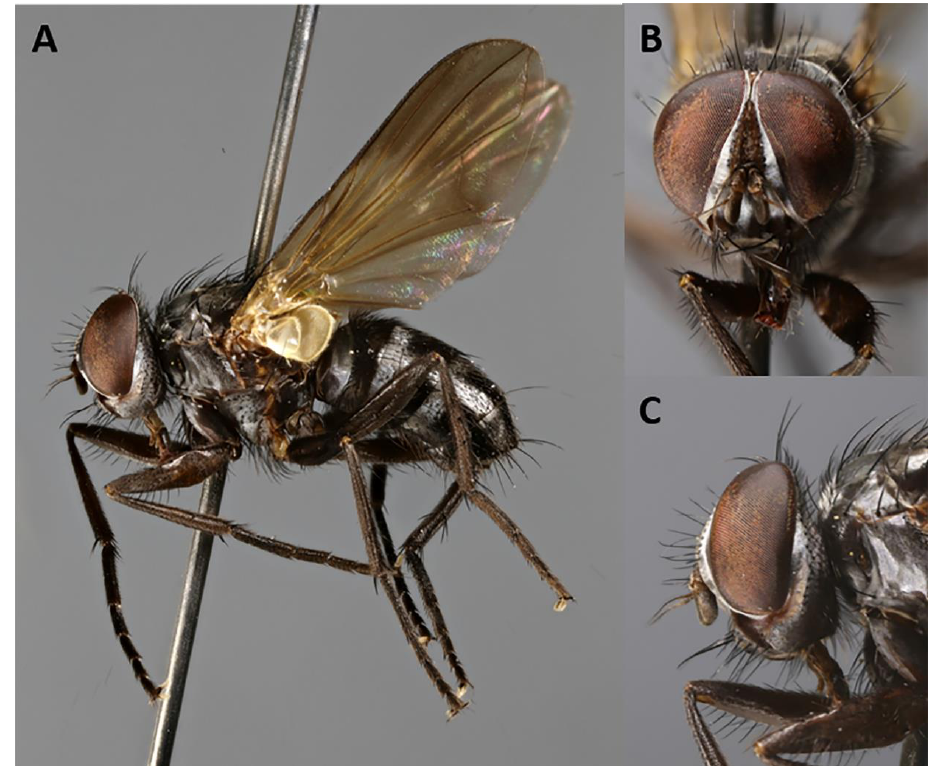
Figure 4. Baniassa pennata sp. nov. (holotype ♂ , BLKU). ( A ) Habitus in lateral view; ( B ) head in frontal view; ( C ) head in lateral view.